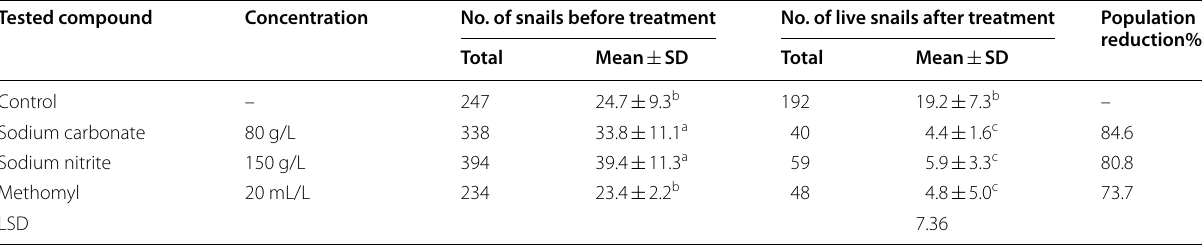
a Significant, b non significant at p < 0.05